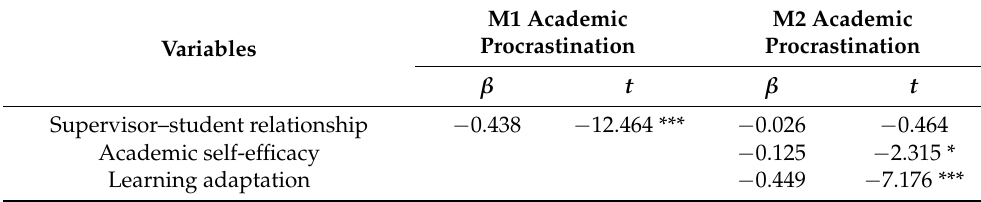
Table 2. Results of the regression analyses (N =